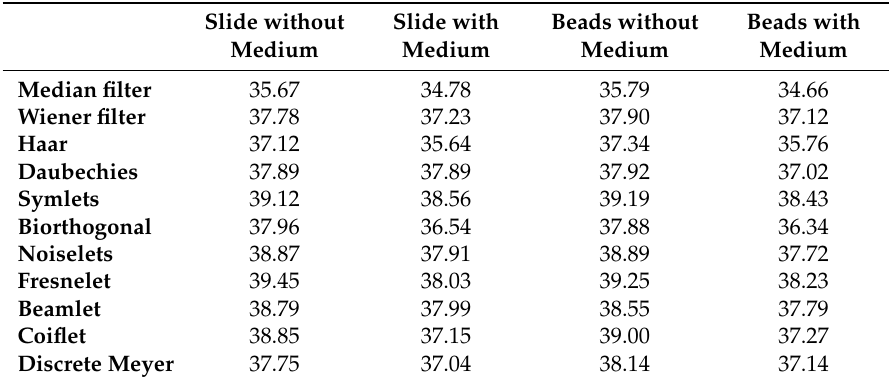
Table 1. SNR values resulting from the application of different filters to depth maps obtained from microbeads and the reference slide.